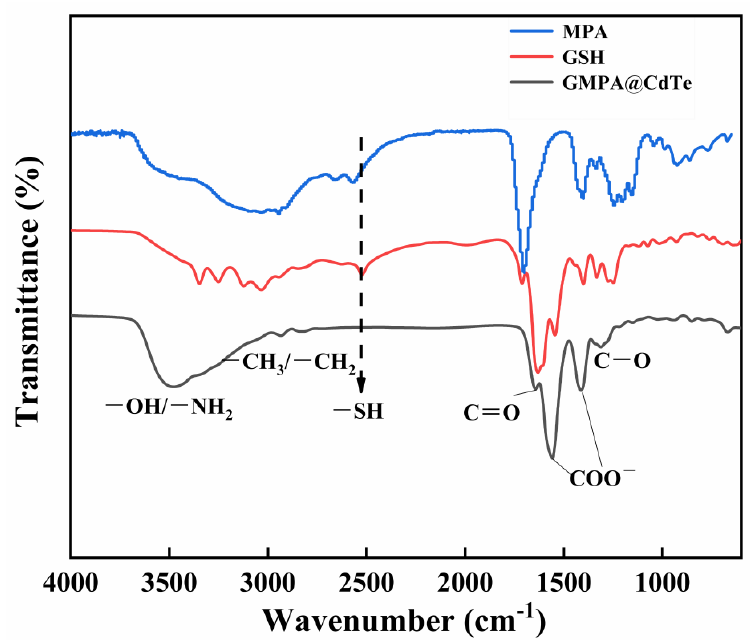
Figure 3. FTIR spectra of MPA, GSH, and GMPA@CdTe QDs.